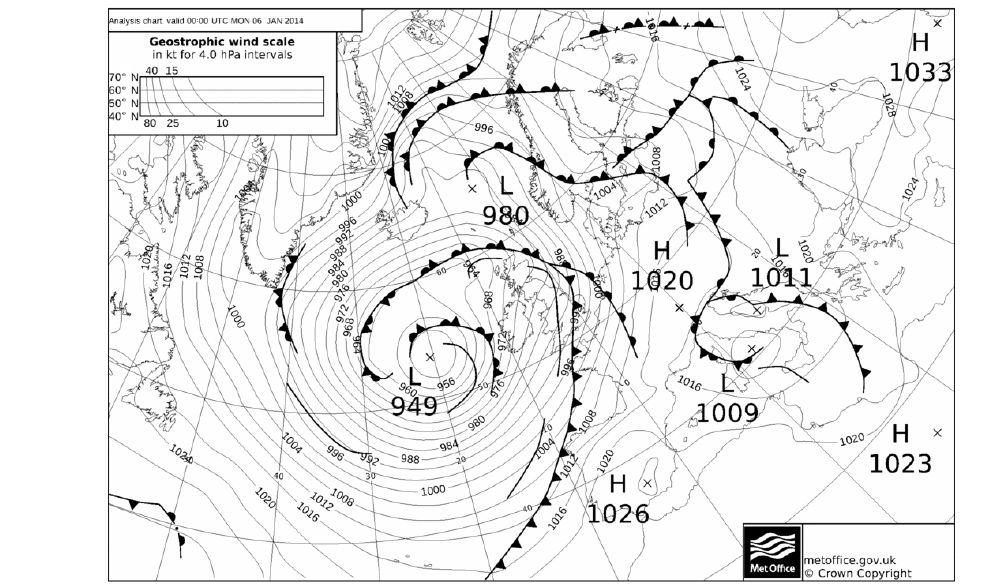
Figure 11. Synoptic chart of the storm “Hercules” on 6 January 2014 at 00:00UTC. © Crown Copyright (Met Office, UK).